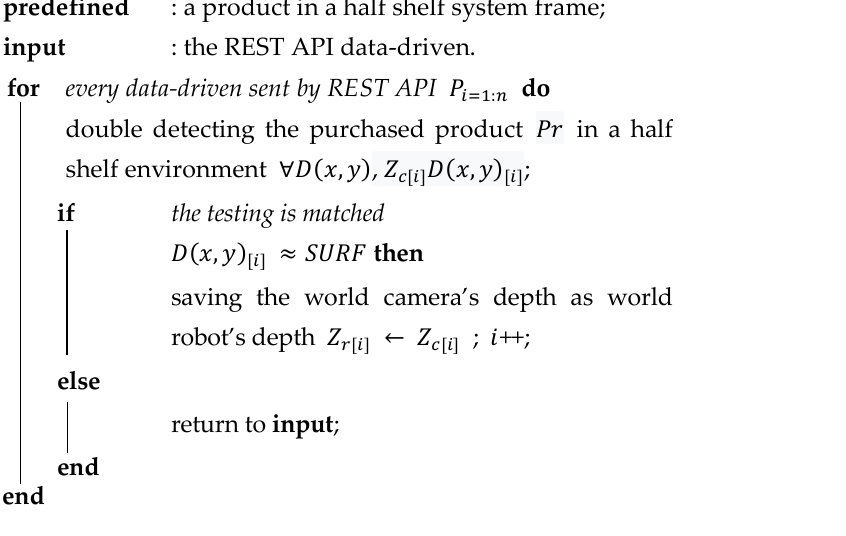
Algorithm 1 Search Purchased Product in A Half Shelf